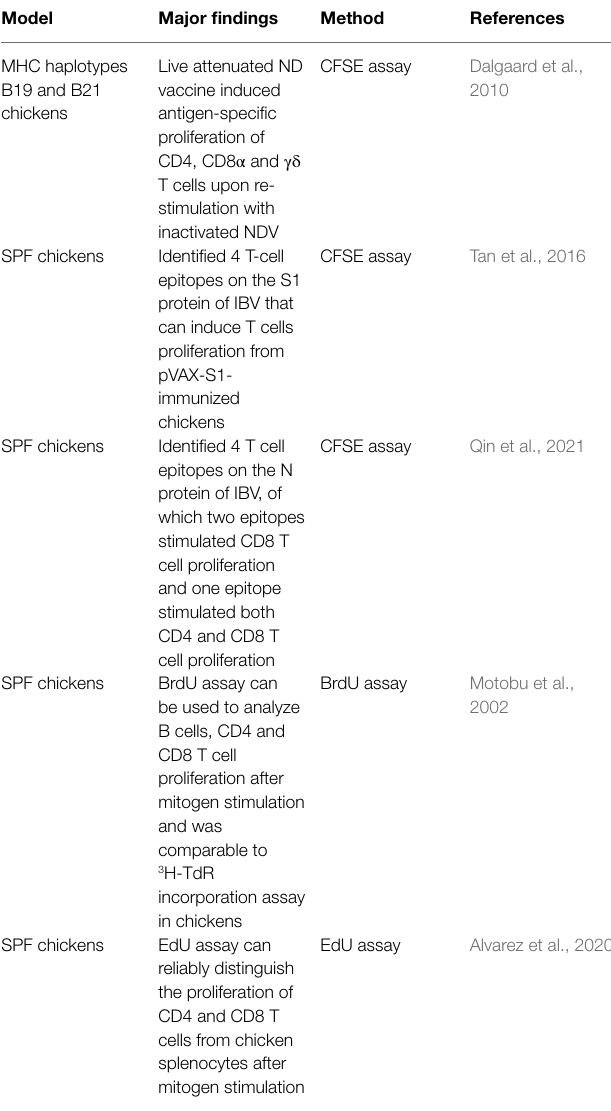
TABLE 2 | Flow cytometry-based proliferative assay of T cells in